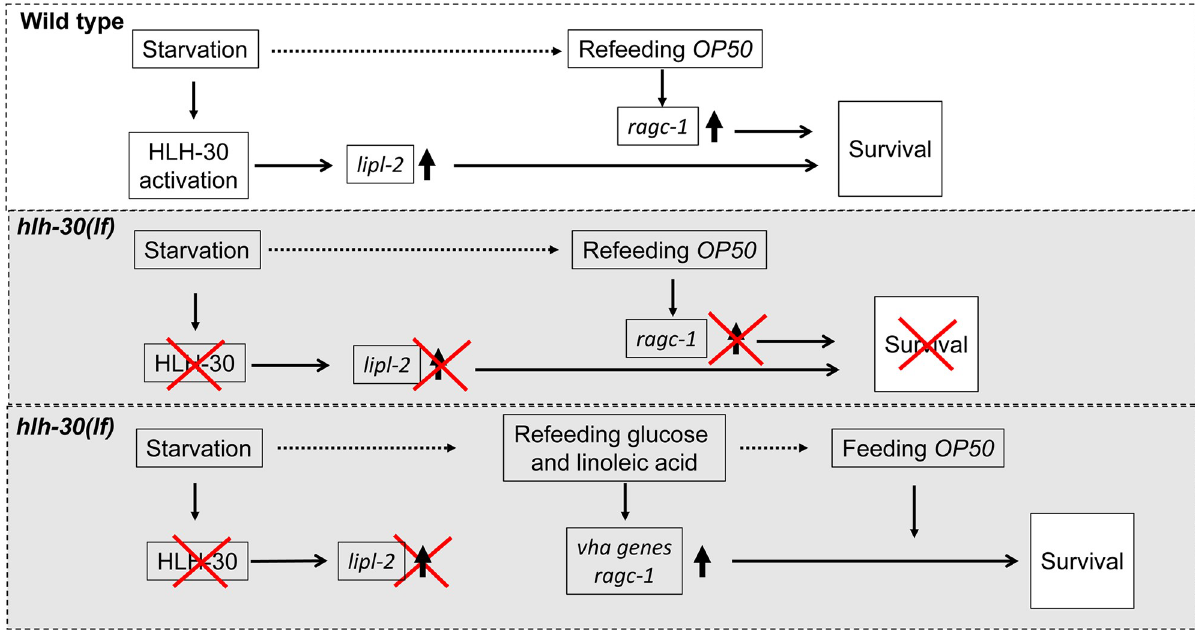
Fig 8. Schematic depicting pathways whereby simple nutrients bypass hlh-30 to promote survival under starvation conditions. Under starvation stress, wild-type worms activate hlh-30 –dependent expression of target genes such as lipl-2 (a lysosomal lipase) via inducing cytosol to nuclear translocation of HLH-30 ( top panel ). lipl-2 induction plays a critical role in starvation survival. Refeeding with E . coli OP50 triggers increased ragc-1 transcript levels, which couple nutrient sensing on acidified lysosomes and TOR activation to survival ( top panel ). In starved hlh-30 –deficient worms, lack of HLH-30–induced transcription impairs lipl-2 up-regulation and is accompanied by reduced ragc-1 levels upon refeeding ( middle panel ). Starved hlh-30 –deficient worms demonstrate marked energy deficiency with decreased lysosome abundance, leading to death despite refeeding with E . coli OP50 ( middle panel ). Refeeding starved hlh-30 –deficient worms with CeMM provides simple nutrients, namely glucose and linoleic acid, which restore ATP levels and induce nhr-31 –mediated vha gene transcription ( bottom panel ). CeMM refeeding also restores ragc-1 expression and lysosome acidification and abundance and sustains survival with subsequent E . coli OP50 feeding ( bottom panel ). Impaired TOR activation with rapamycin treatment and loss of ragc-1 prevent nutrient sensing to TOR upon refeeding following starvation, and rapamycin prevents CeMM rescue in starved hlh-30 –deficient worms. Horizontal black arrows indicate causal relation. Horizontal dotted arrows indicate transition from starvation to refeeding. Upward arrows indicate increased levels. Red cross marks indicate absence of the indicated event. CeMM, C . elegans maintenance medium; hlh-30 , basic helix–loop–helix transcription factor 30; hlh-30(lf) , loss-of-function tm1978 mutation hlh-30 ; lipl-2 , lysosomal lipase 2; nhr-31 , nuclear hormone receptor 31; ragc-1 , the ortholog for mammalian RagC/D GTPases; TOR, target of